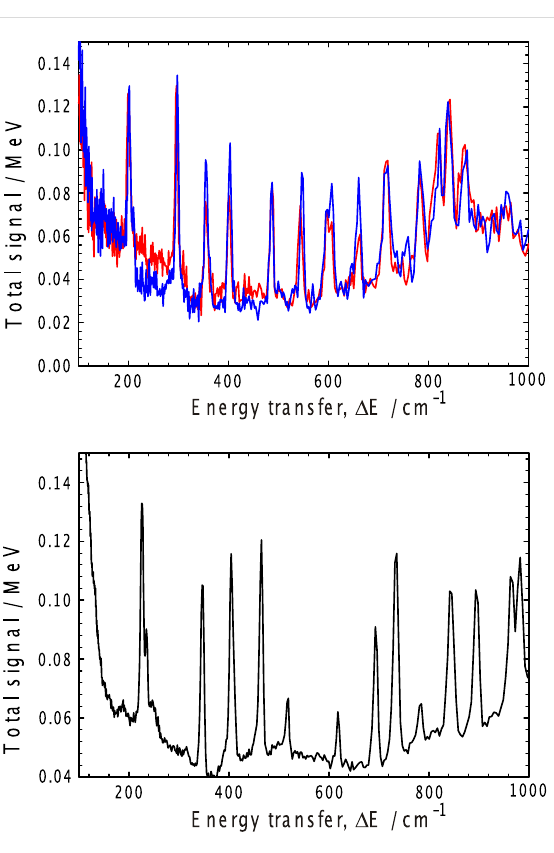
Figure 9: Inelastic neutron spectroscopy from cyclohexane gels (upper Figure): red deuterated cyclohexane/hydrogenous gelator, blue deuter- ated cyclohexane/deuterated gelator, and the pure solvent (lower